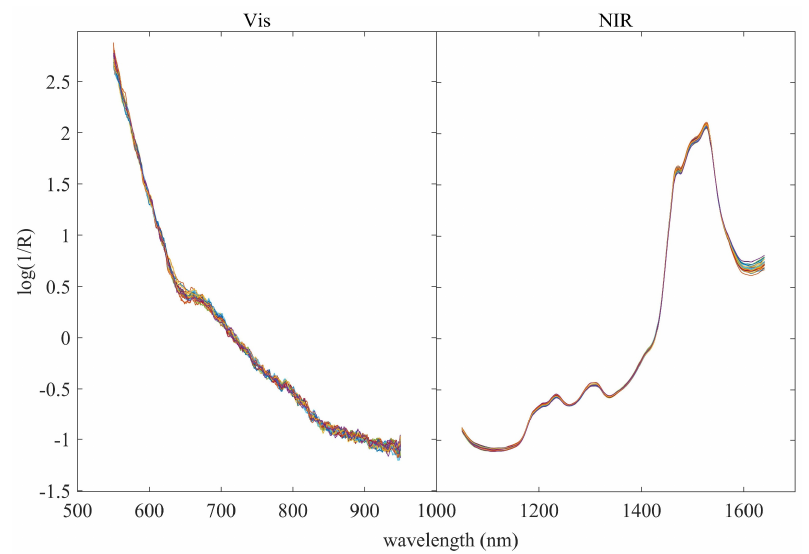
Figure 4. Spectral curves of fertilizers after preprocess (each color of the curve in the figure repre- sents the spectrum of a sample).